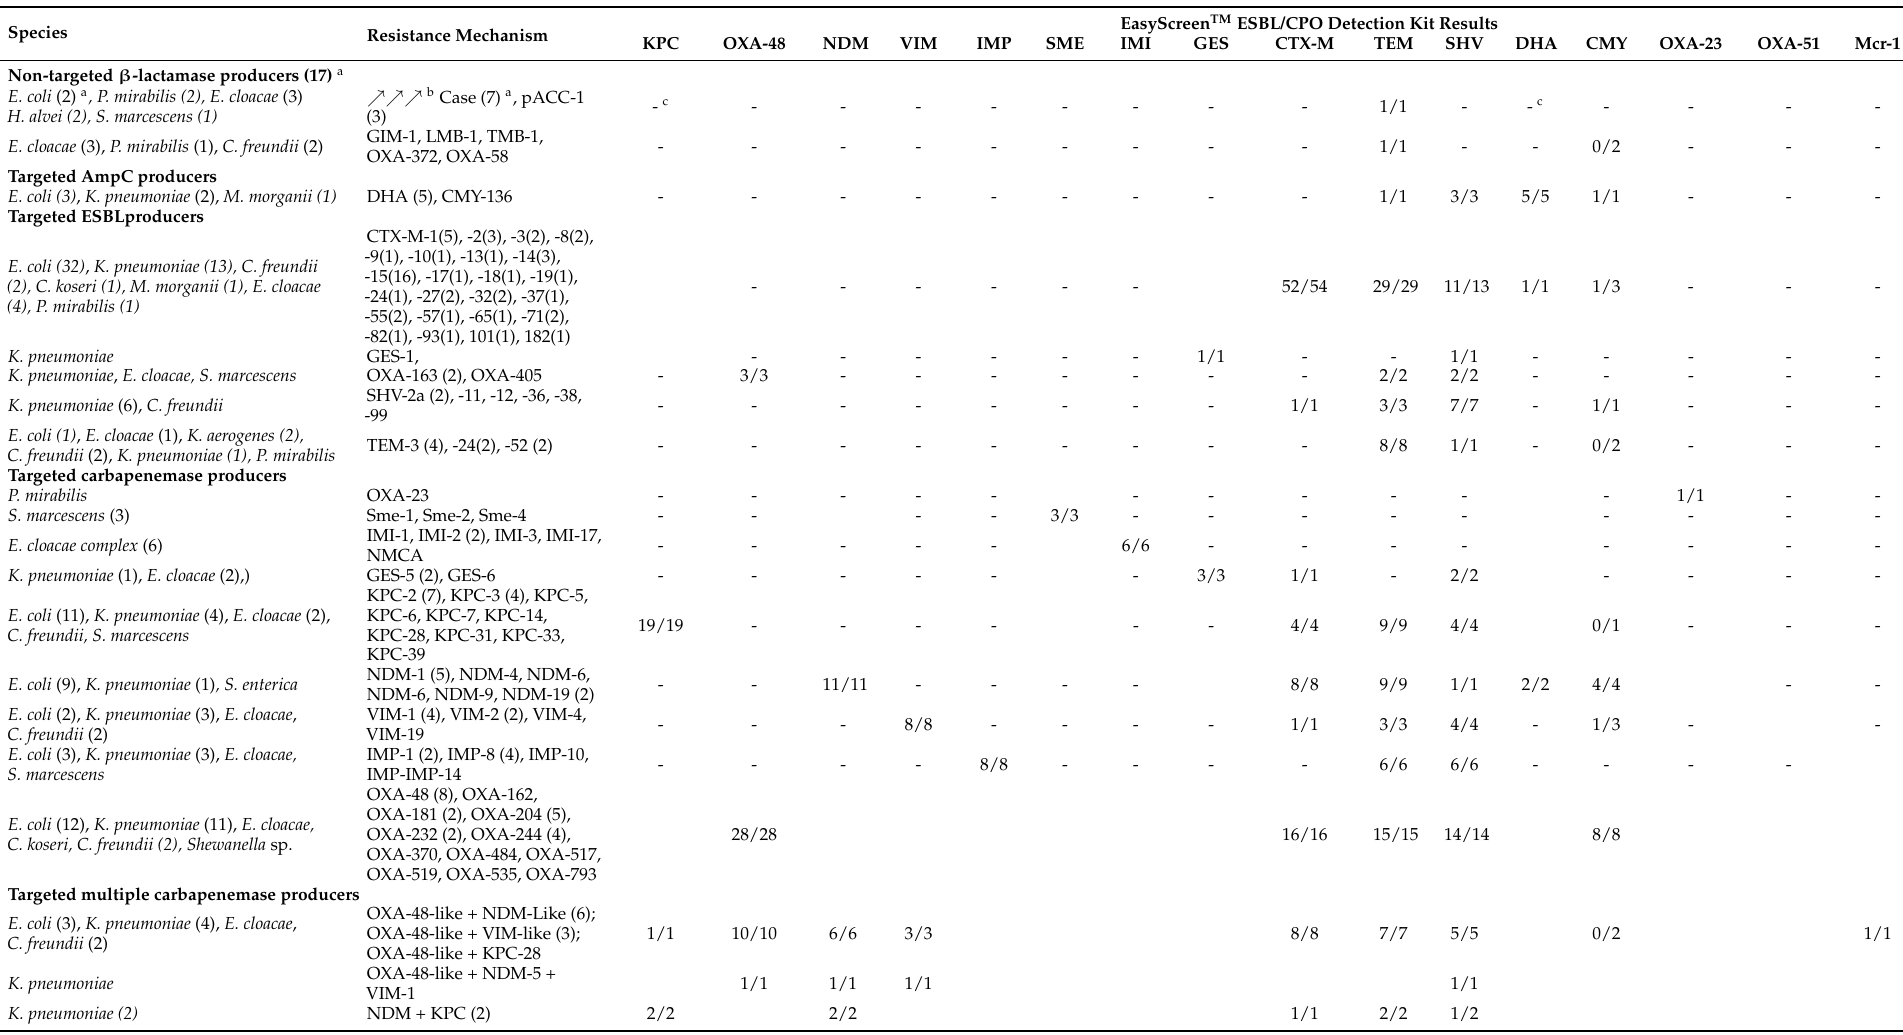
Table 2. Global performances of the EasyScreen TM ESBL/CPO Detection Kit on Enterobacterales isolates colonies grown on MH agar (n =